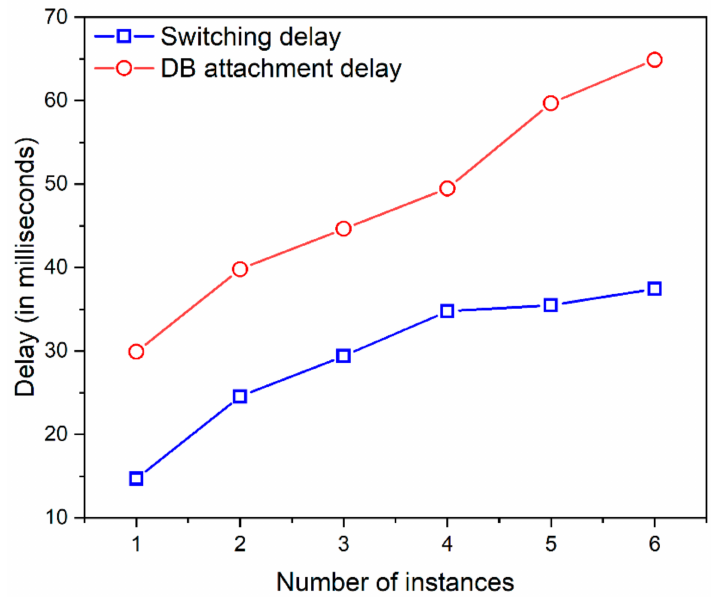
Figure 10. MTD delay estimation metrics observed in